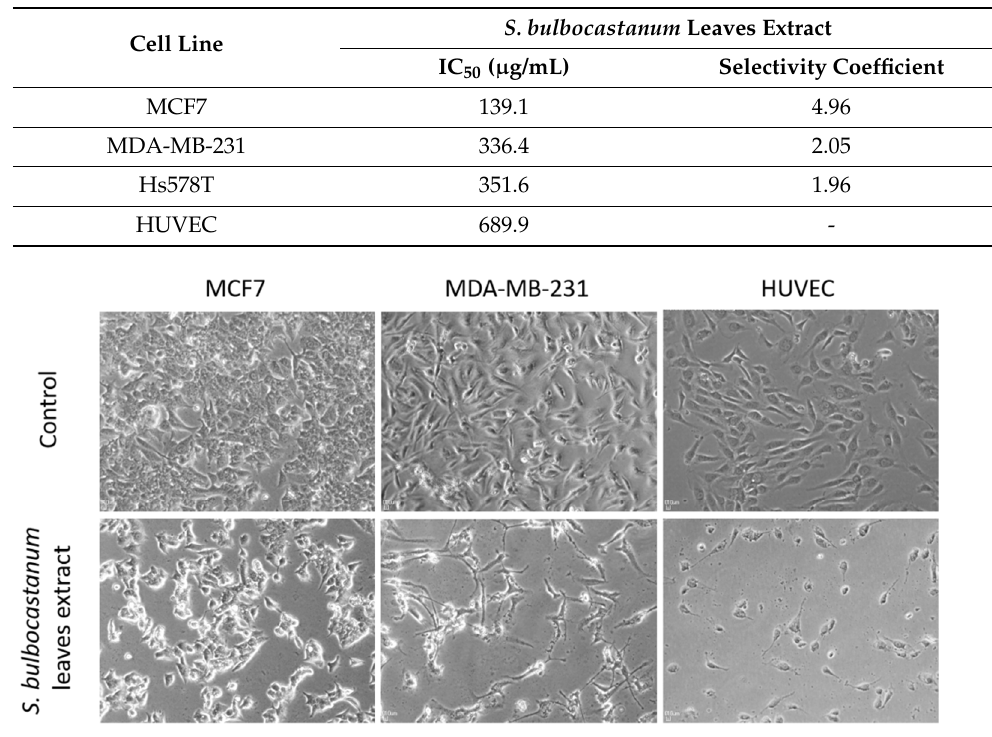
Table 3. The IC 50 values and the selectivity coefficients in the antitumor action for S. bulbocastanum leaves extract against MCF7, MDA-MB-231, Hs578T and HUVEC cell lines, at 48 h after administration. The IC 50 values are means for three biological replicates.